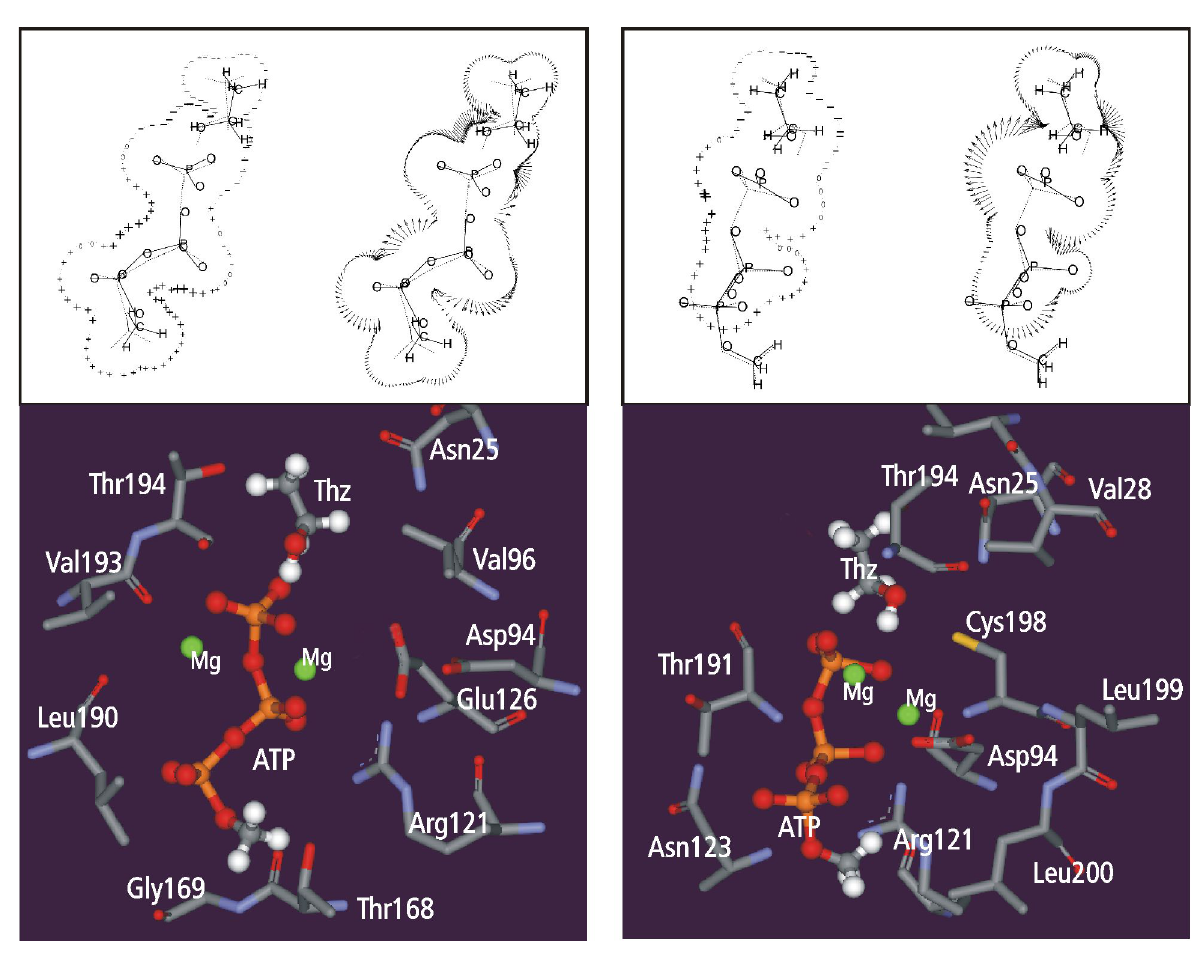
Figure 5 . Symbolic representations of the differential electrostatic properties for two perpendicular planes ( the top of the figure ) . Superimposed structures of both substrates (dotted lines, position of bonds only) and transition state (full line s ) are presented. The bottom part of the figure: s ubstrate binding pockets presented from views corresponding to plots (amino acid residues presented in stick representation )